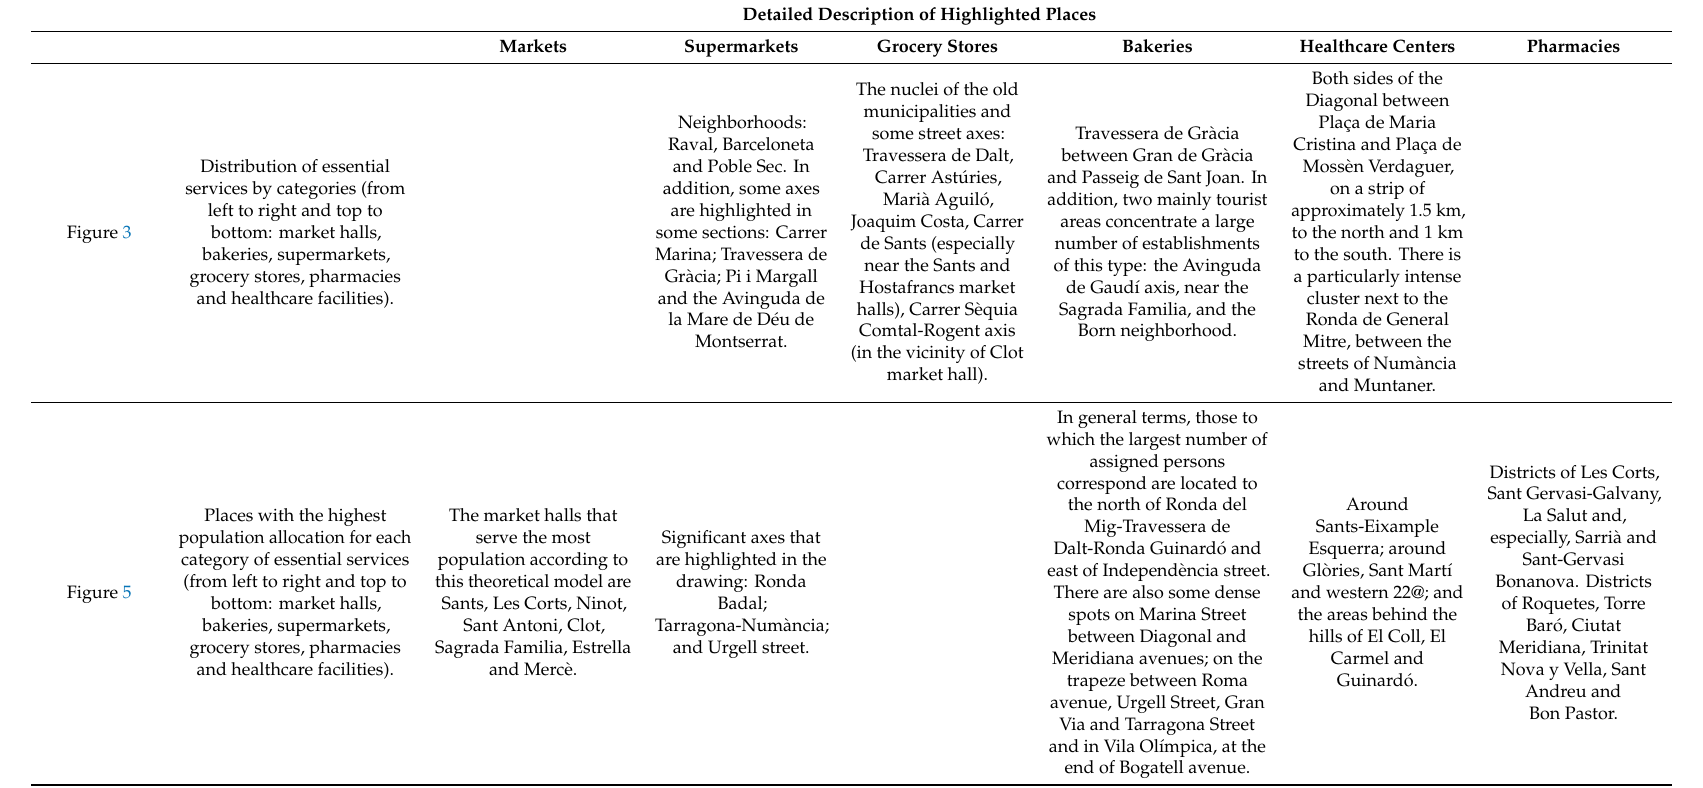
Places with the highest population allocation for each category of essential services (from left to right and top to bottom: market halls, bakeries, supermarkets, grocery stores, pharmacies and healthcare